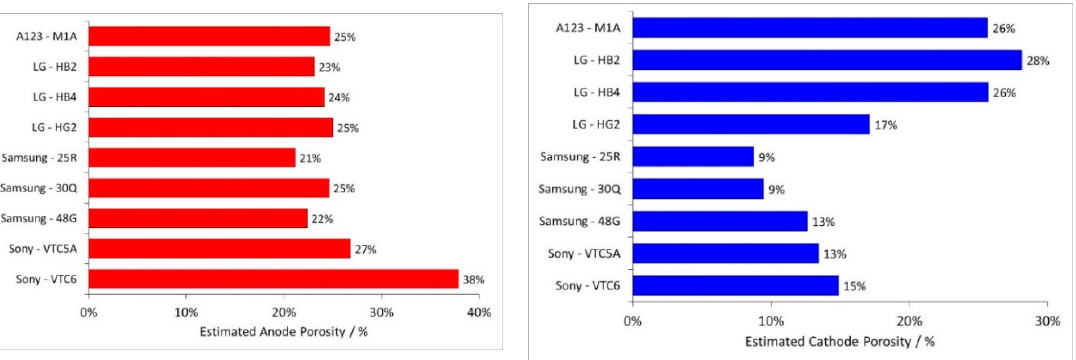
Figure 6. Calculated porosity values for anode and cathode coatings.